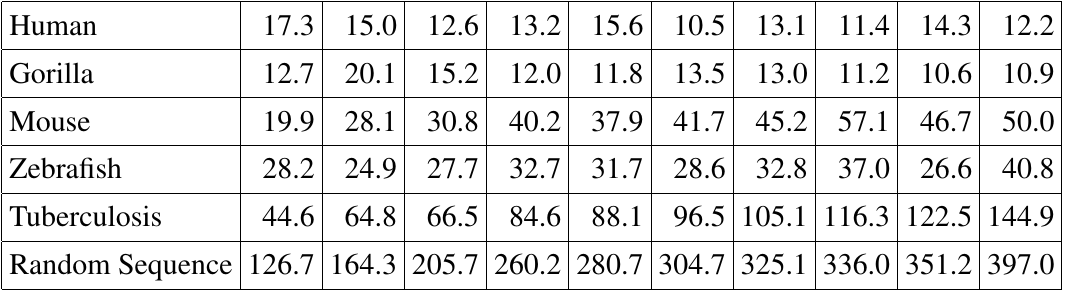
Table 2: The ratio maxmdv/mdv computed for substrings of length { 1 , . . . , 10 } × 10 5